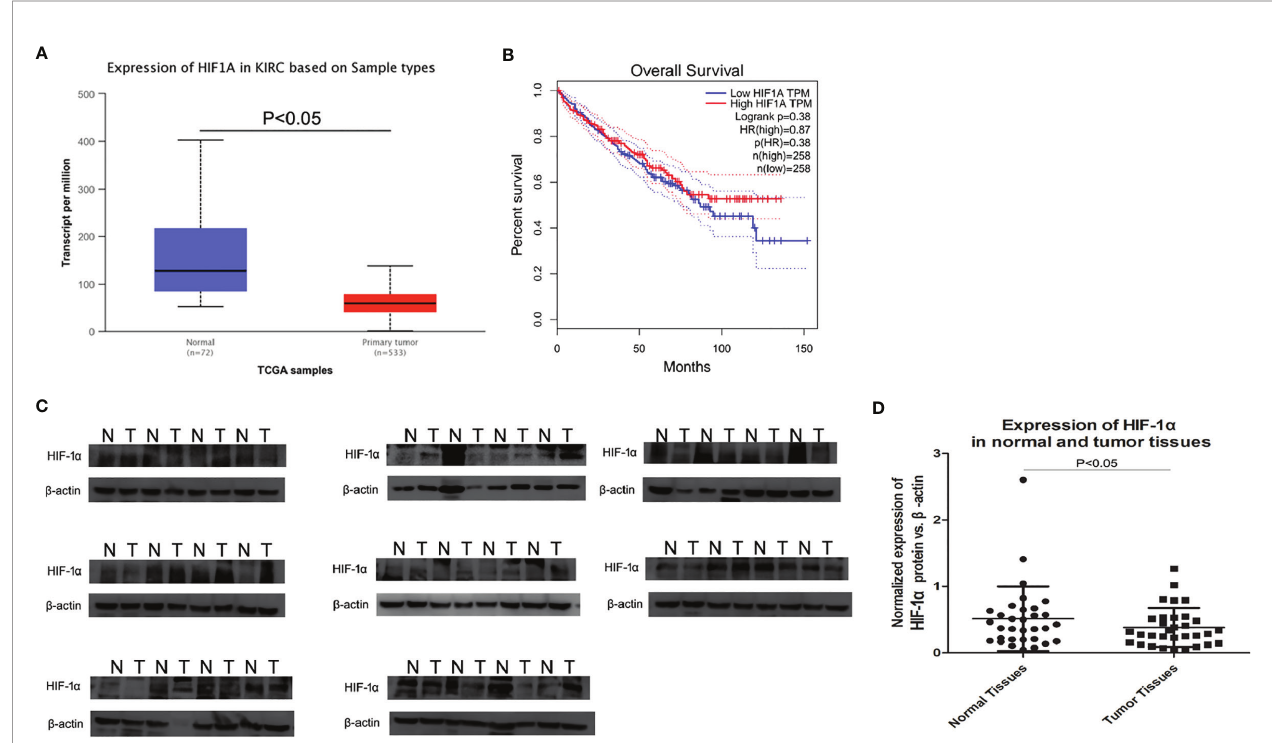
FIGURE 1 | Expression of HIF-1 a by TCGA and western blot in ccRCC tissues and normal renal tissues. (A) HIF-1 a expression was signi fi cantly down ‐ regulated in ccRCC tissue compared to that in non ‐ tumor tissues, P <0.001. (B) HIF-1 a expression had no correlation with overall survival in ccRCC. (C) The average HIF-1 a expression for all studied ccRCC tissues and corresponding normal rnal tissues (32 cases) by western blot. (D) Scatter plot (vertical) graphs describe conspicuous HIF-1 a downregulation in ccRCC tissues in comparison with normal tissues (P <0.05). b -actin was used as the control for normalization. “ N ” represented normal renal tissues; “ T ” represented ccRCC